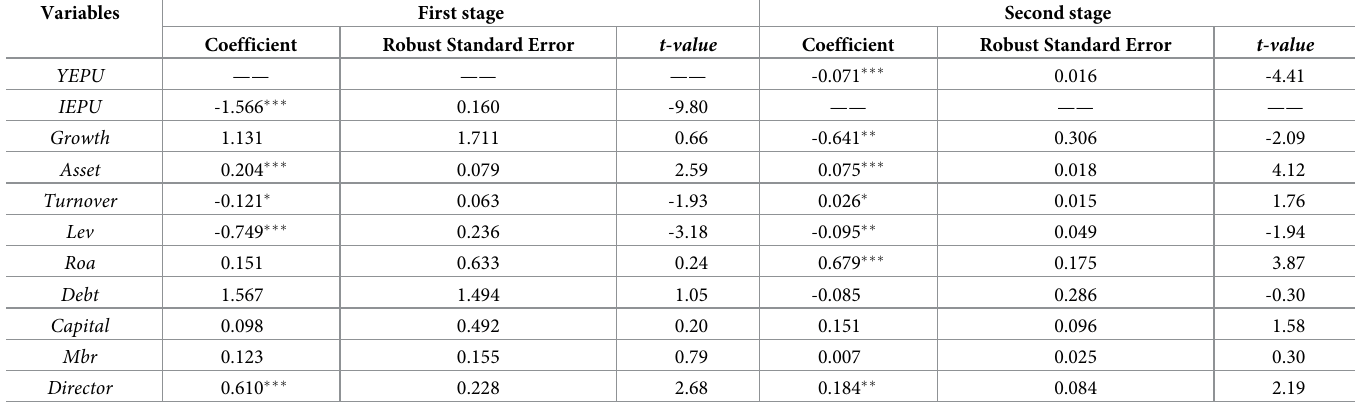
Table 3. Regression results for instrumental variables.